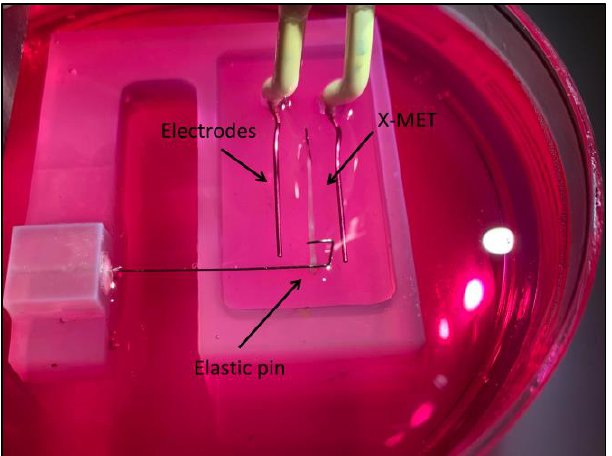
Figure 2. Picture of the sensor integrated with the platinum electrodes for the electrical stimulation of the tissue. One end of the specimen is pinned in the silicone substrate, and the other end is linked to the elastic pin. The entire sensor is placed in a 90 mm diameter Petri dish.